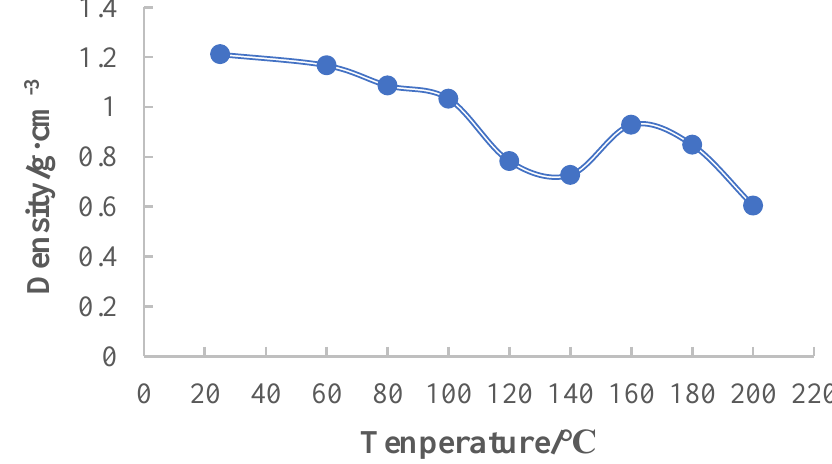
Figure 10. The density value versus the temperature.